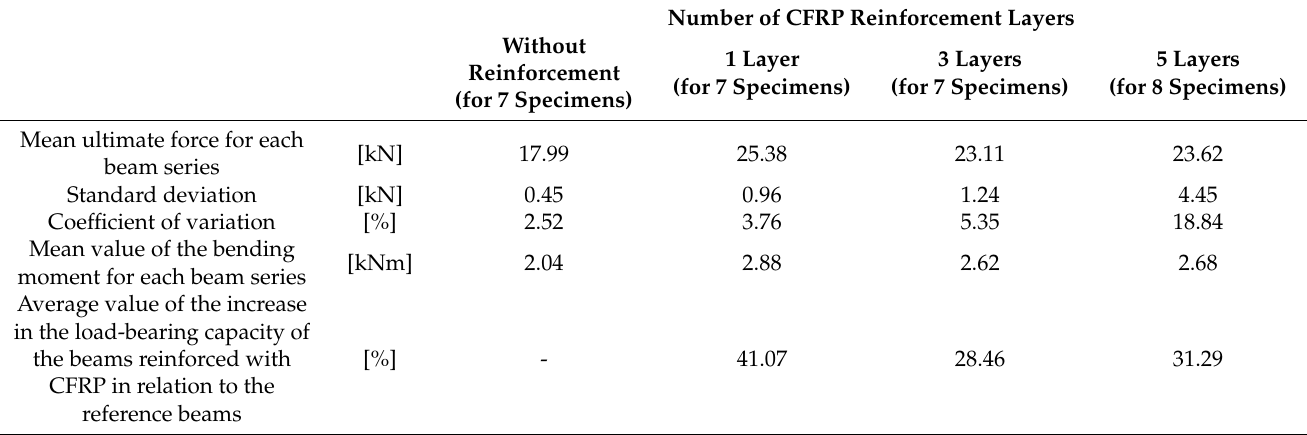
Table 3. Comparison of load-bearing capacities for the beams in the various series.